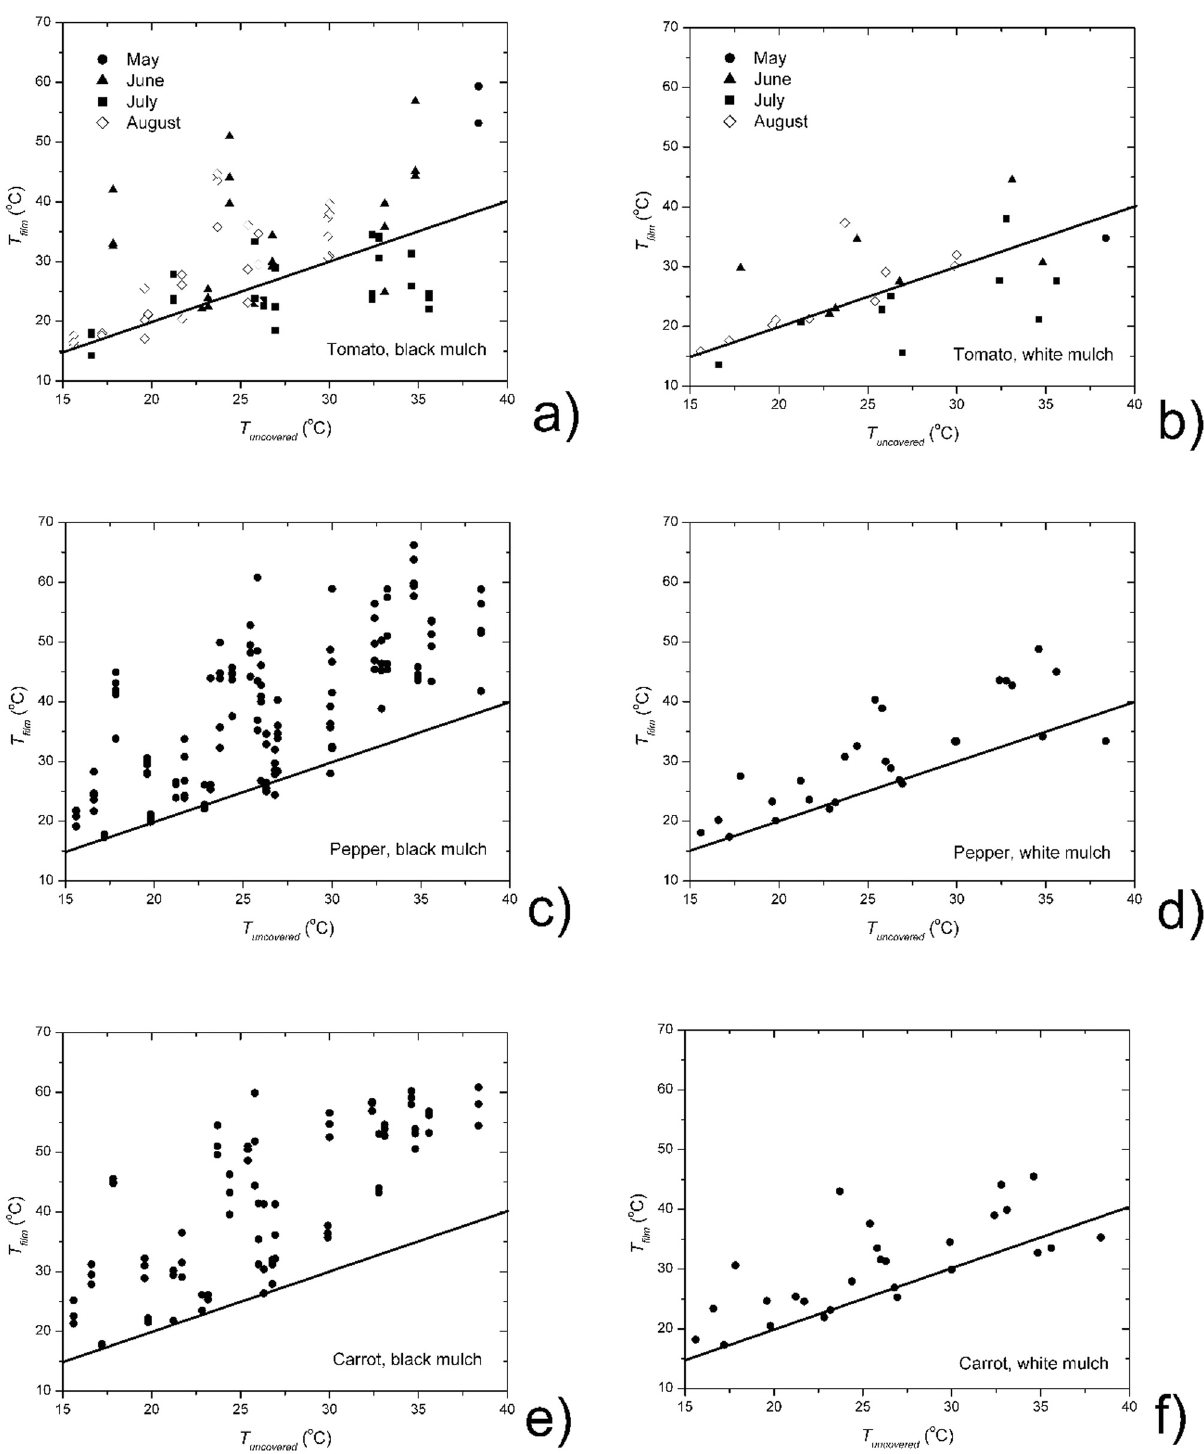
Figure 3: Film temperature measured for each plot as a function of the temperature of the soil surface in the bare plot. Measurements are separated according to the colour of mulch and the plant grown: ( a ) black fi lm with tomatoes, ( b ) white - on - black fi lm with tomatoes, ( c ) black fi lm with peppers, ( d ) white - on - black fi lm with peppers, ( e ) black fi lm with carrots and ( f ) white - on - black fi lm with